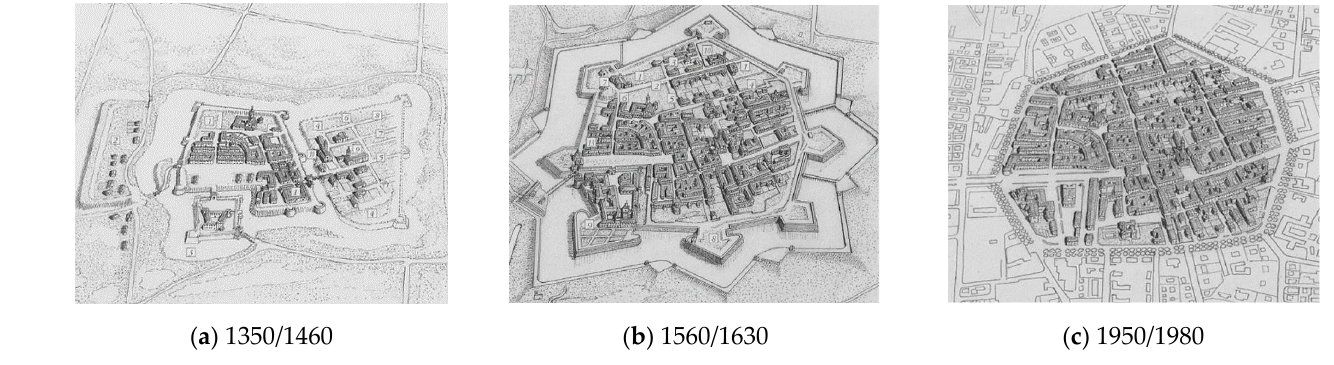
Figure 1. Historical-urban development of the city of Mirandola